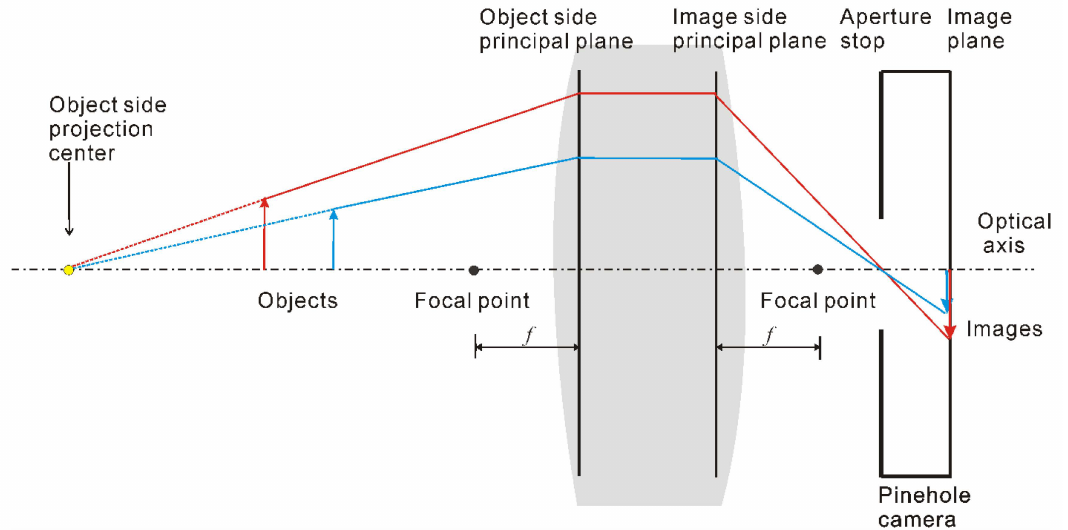
Figure 3. Model of a hypercentric lens.